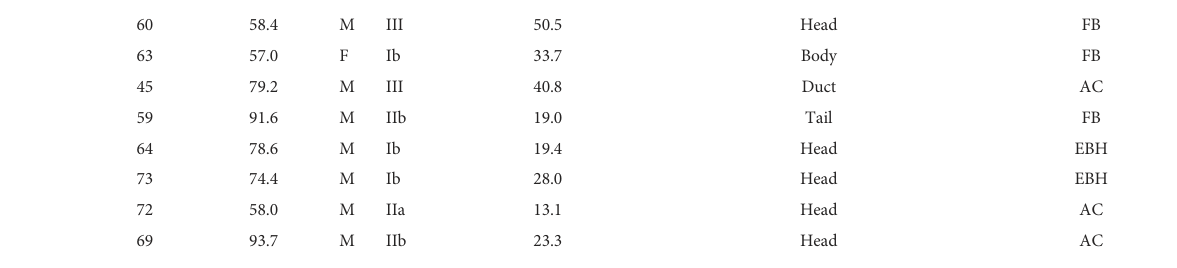
TABLE 1 The characteristics and tumour staging of patients treated with in MASTERPLAN pilot